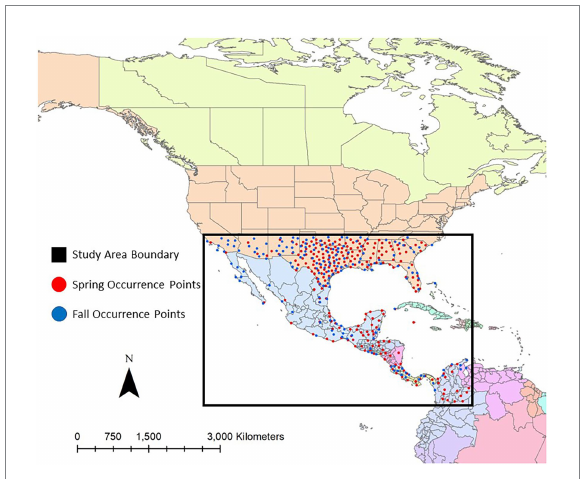
FIGURE 1 Map of the study area, representing the core of most Dickcissel migratory routes. Dickcissel occurrence points within this study area were used to estimate how habitat suitability for migrating Dickcissels relates to climate and landcover variables. Dickcissel occurrence points during spring migration are represented as red dots, and occurrence points during fall migration are represented as blue